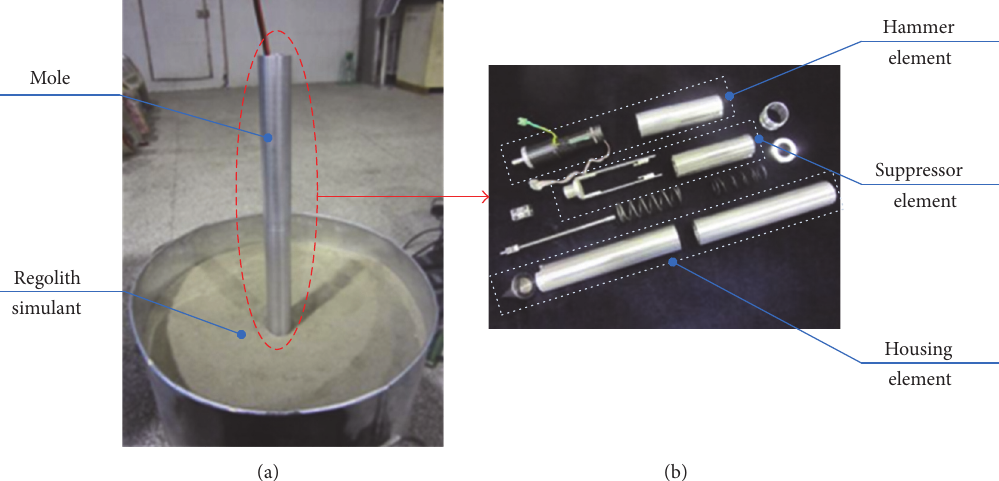
Figure 1: The prototype of HIT-1 penetrator: (a) experimental process of HIT-1 penetrator; (b) structures of HIT-1